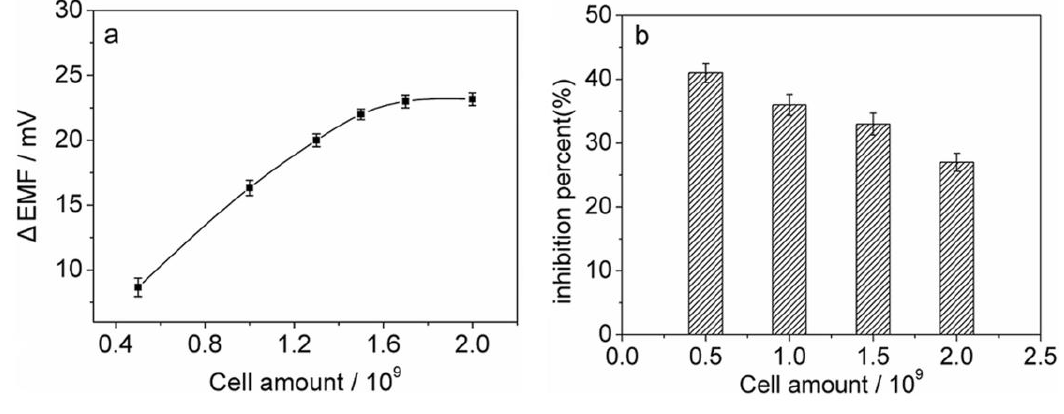
Figure 3. ( a ) Effect of the amount of immobilized cells on the potential response. ( b ) The inhibition sensitivities of different amounts of immobilized cells to 0.3 μM thioacetamide. The other conditions are given as in Figure 2. Each error bar represents one